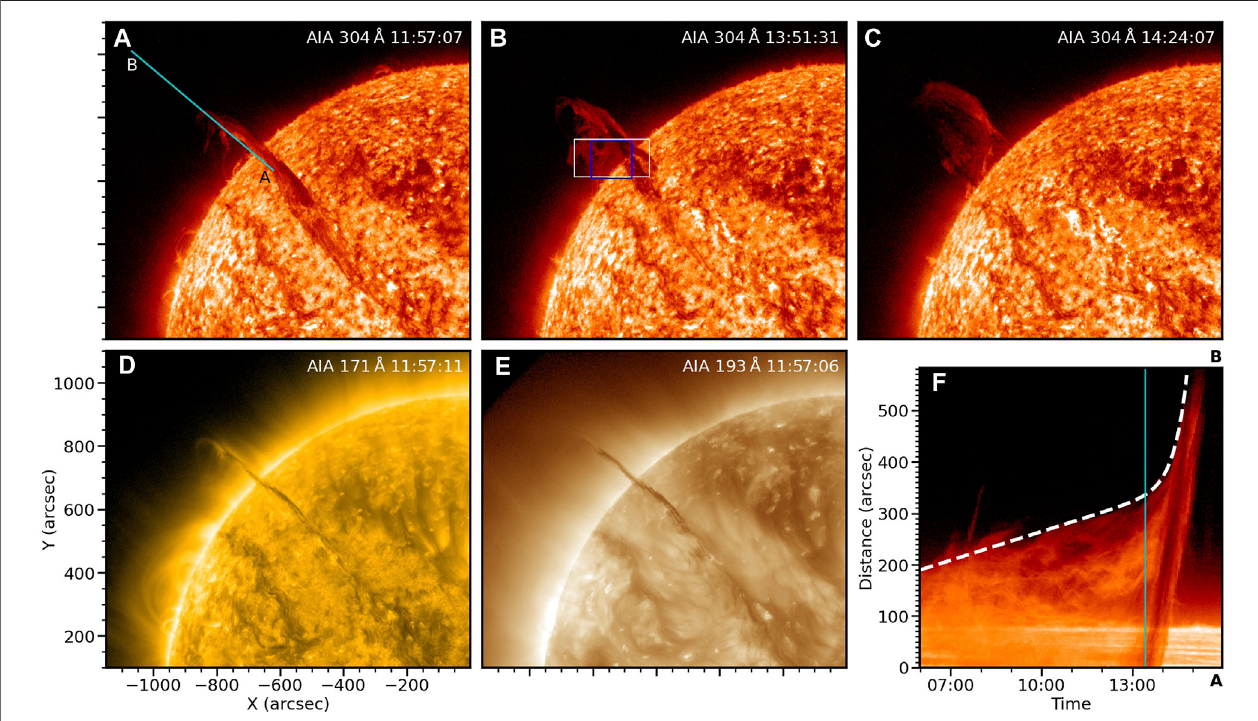
FIGURE 1 | Evolution of the eruptive prominence in EUV images. (A – C) AIA 304 (cid:1) A images. The cyan slice AB in (A) is the position of the time-distance diagram in panel (F) . The white box in (B) represents the FOV of IRIS SJI observations, and the blue box marks the FOV of spectroscopic observations. (D – E) AIA 171 and 193 (cid:1) A images, respectively. (F) Time-distance diagram along the slice AB in panel (A) from AIA 304 (cid:1) A images. The cyan line marks the onset of the fast-rise phase.